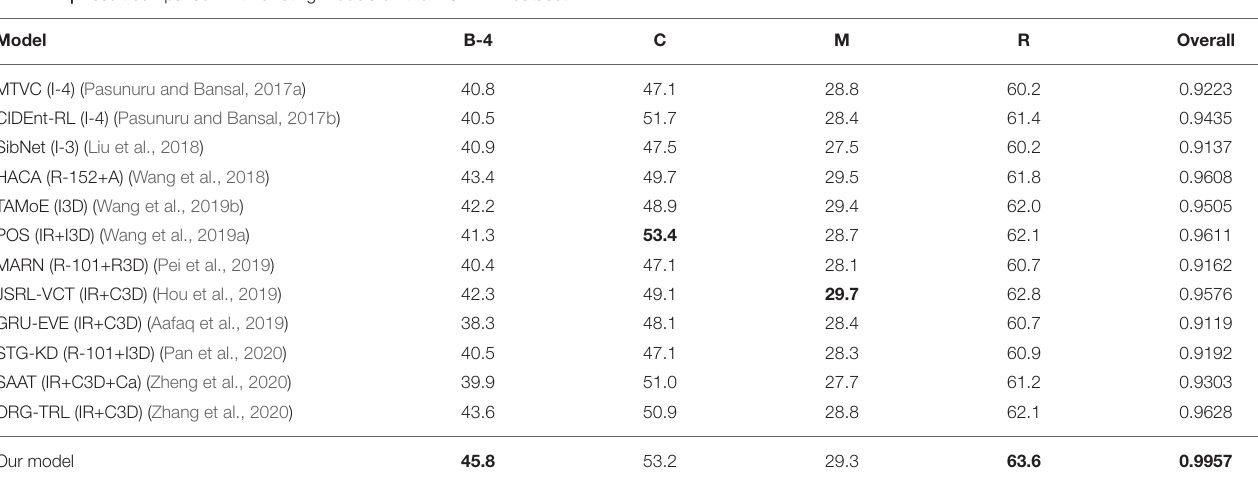
TABLE 2 | Result comparison with existing models on the MSR-VTT dataset.